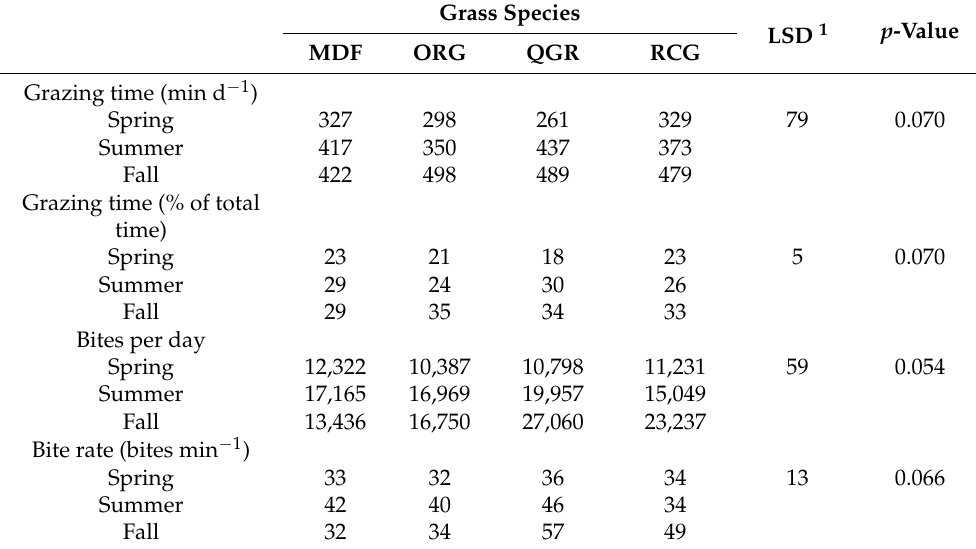
Table 4. Grass species–season interaction for grazing time, bites per day, and bite rate of four grass species (meadow fescue—MDF; orchardgrass—ORG; quackgrass—QGR; reed canarygrass—RCG). Means are average of two years. Grass Species LSD 1